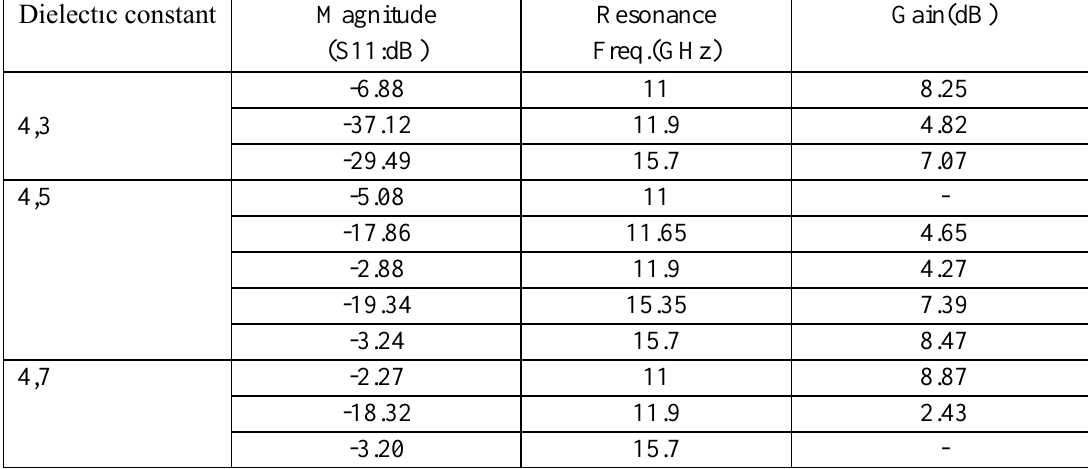
Table 4. S11 and gain results with different dielectric